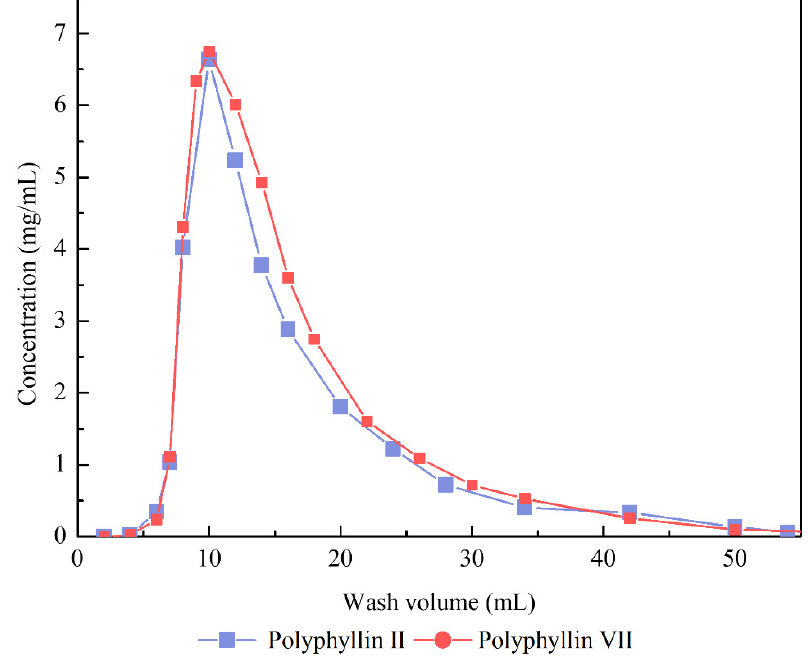
Figure 9. Isocratic elution curve of polyphyllin II and polyphyllin VII by 60% ( v / v ) ethanol.